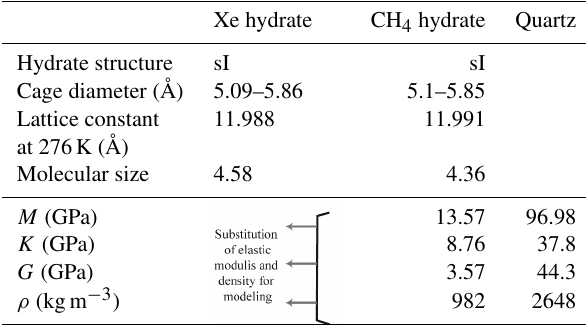
Table 1. Comparison of crystallographic properties of xenon and methane hydrate (Hansen et al., 2016). Second part of the table de- picts the elastic moduli later assigned for modeling the effective elastic properties. Values of M ( P wave modulus), K (bulk modu- lus) and G (shear modulus) (after Helgerud et al., 2003). Table 1: Comparison of crystallographic properties of xenon- and methane hydrate (Hansen et al., 2016). Second part 4 of the table depicts the elastic moduli latter assigned for modelling the effective elastic properties. Values of M (P-